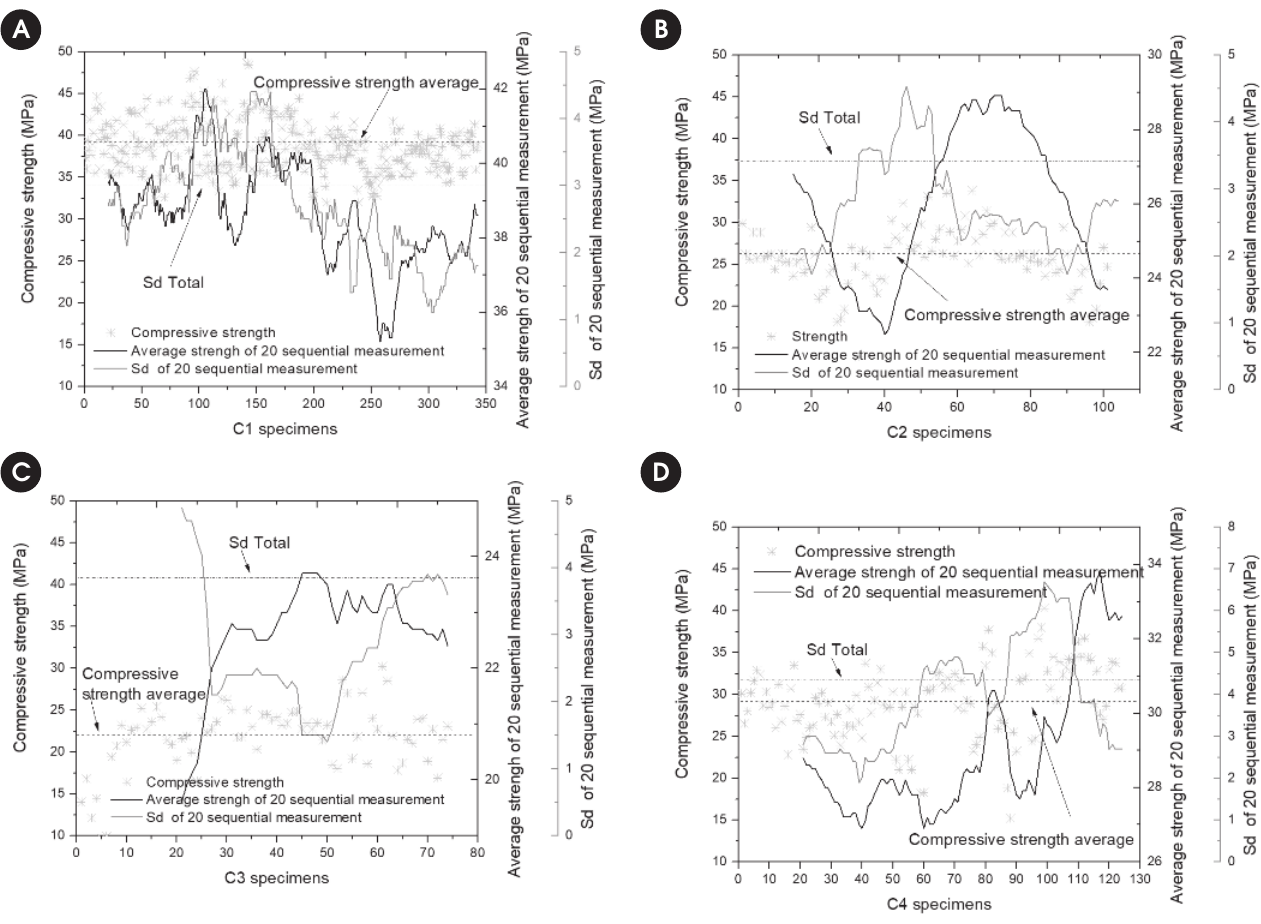
Figure 5 Compressive strength results of C1, C2, C3 and C4